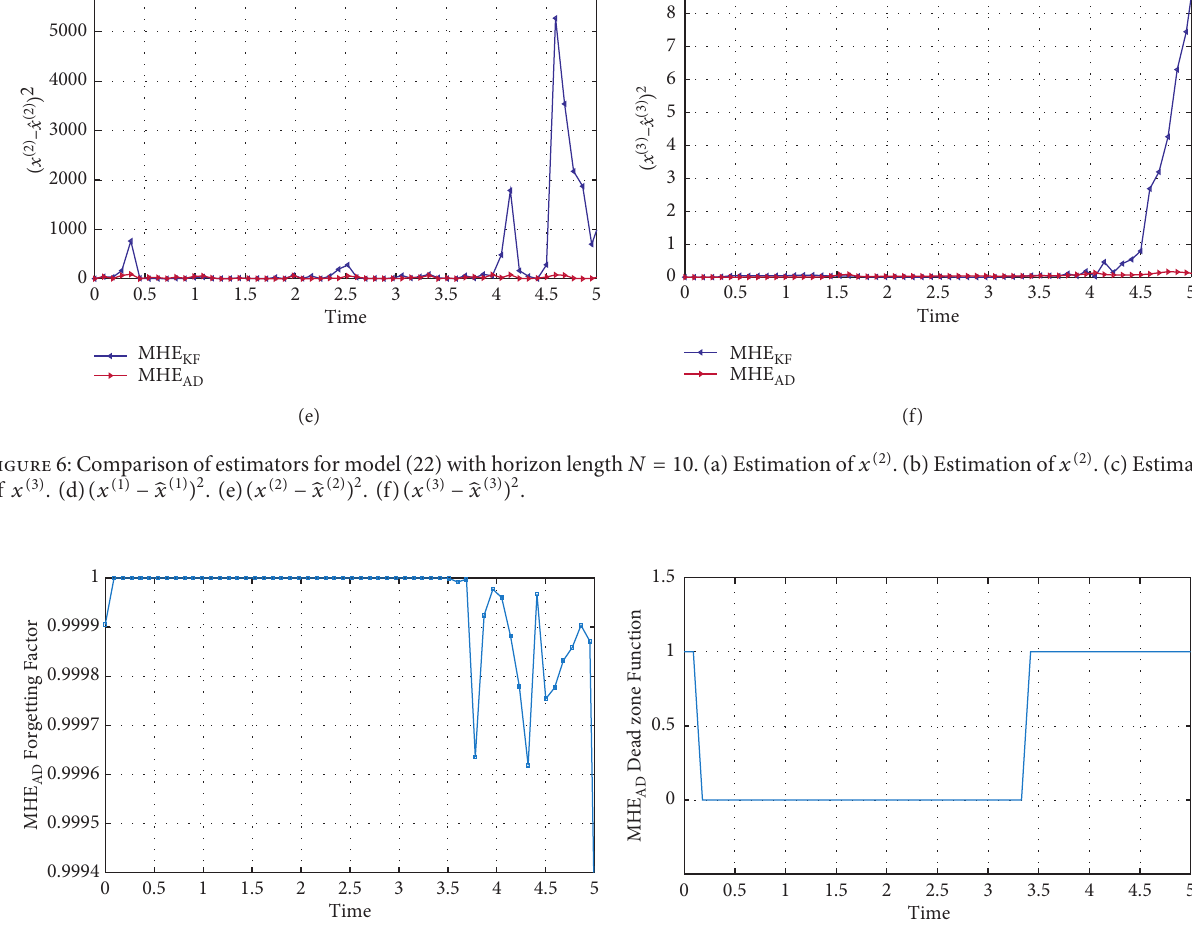
) and (b) dead zone function ( α ℓ